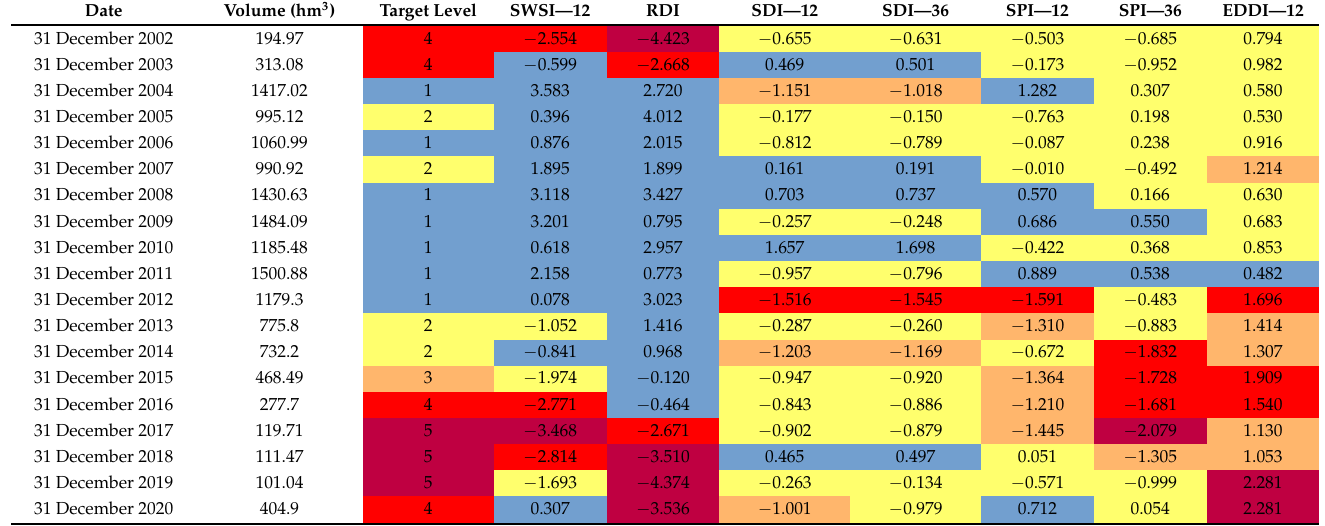
Table 12. Analysis of the indexes in relation to the Target Levels for the Or ó s reservoir.